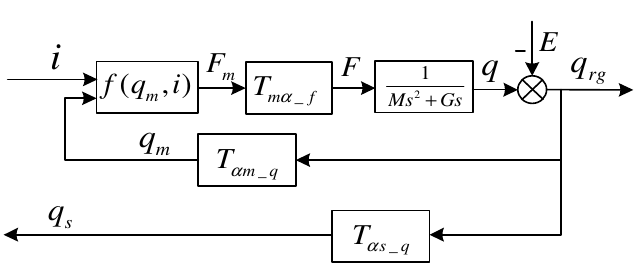
Figure 5. The control block diagram of the